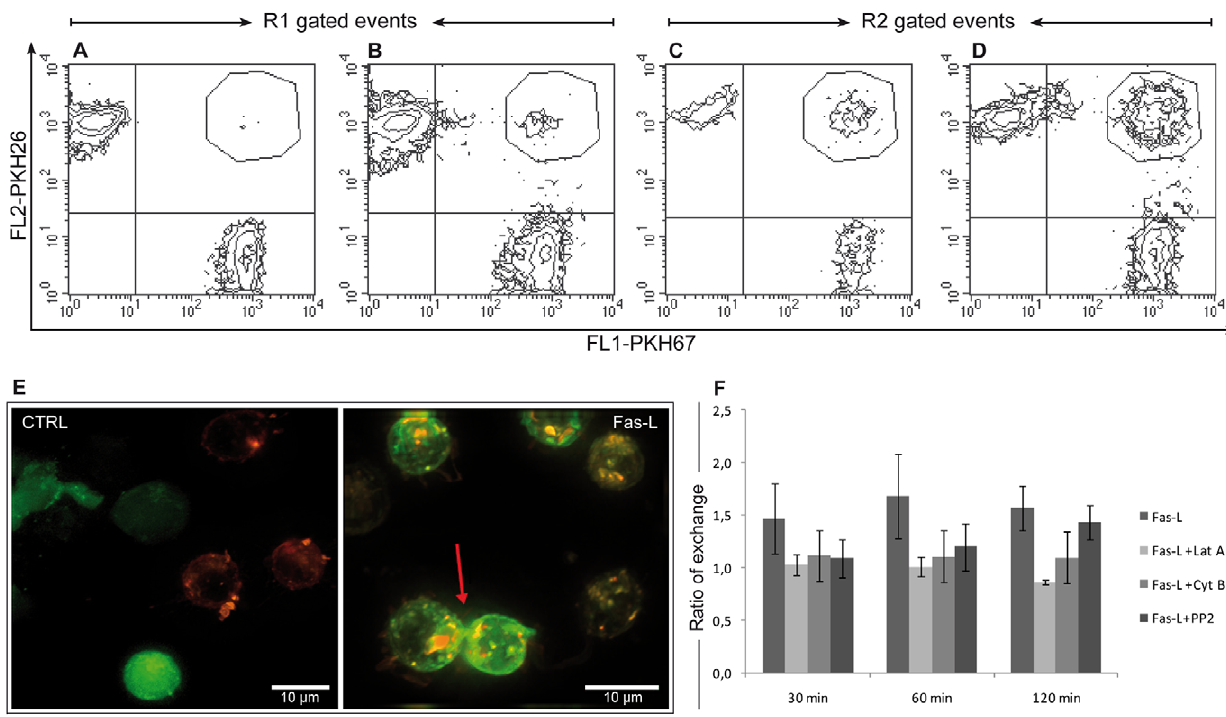
Figure 2. Detection of plasma membrane fragments exchange by PKH26 and PKH67 dyes. PKH26 and PKH67 labelled CD4 + T cells were co-cultured for 30 min without (A,C) or with (B,D) FasL addition. (A,B) represent the events selected by R1 gate (isolated cells) and (C,D) the events selected by R2 gate (cell conjugates) (see Fig. 1). Contour plots highlight an higher double positive events (identified by drawing area) after FasL treatment, in particular within gate R2 than in gate R1. Imaging microscopy (E) shows CD4 + T cells stained with CFSE and DiI at the outset (CTRL) and after 30 min FasL treatment (Fas-L). The tick arrow indicates patches of exchange material between conjugated cells bound also with a nanotube. The PKH67 intercellular exchange (F) was evaluated after FasL treatment with or without different inhibitors, Lat A (Latrunculin A), Cyto B (Cytochalasin B) and PP2. The scatter gram shows a poor membrane transfer (1.5–3 ratio of exchange) which was reduced by pharmacological agents, in particular after Lat A treatment. Results from n=6 separate experiments between FasL and inhibitors cited above were statistically significant (p ,